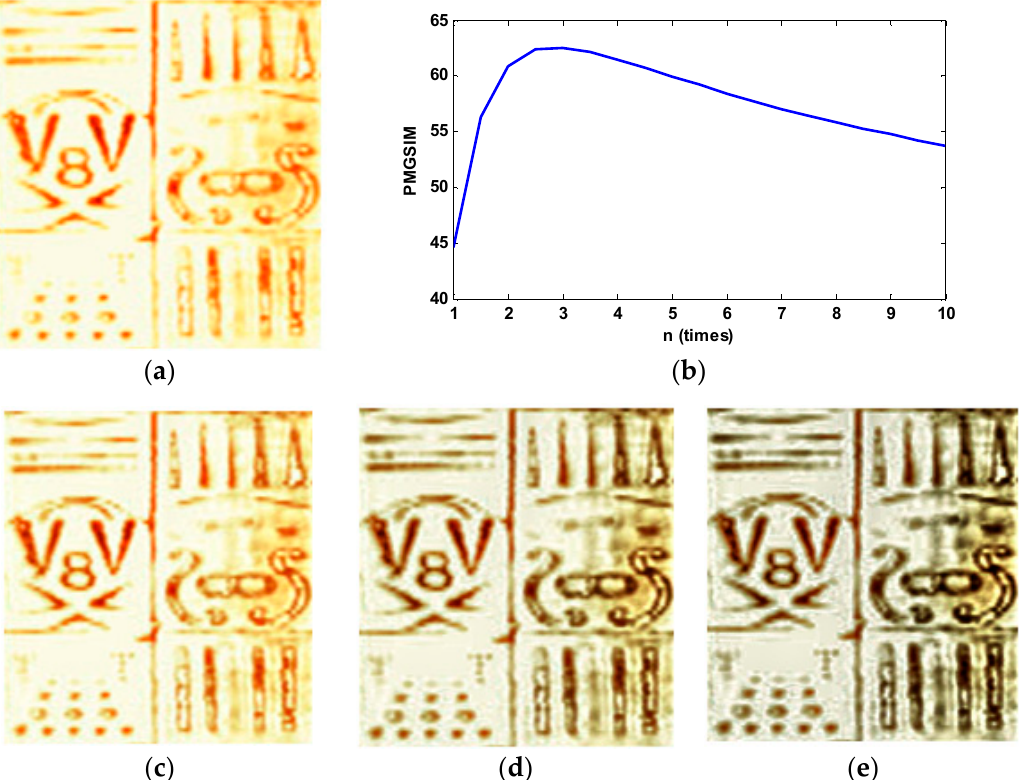
Figure 6. Examples of the proposed POSHEOC with different n values. ( a ) The original ultrasonic logging image; ( b ) PMGSIM of the enhanced image with different n values; ( c ) The enhanced result of the proposed POSHEOC with n = 1.5; ( d ) The enhanced result of the proposed POSHEOC with n = 3; ( e ) The enhanced result of the proposed POSHEOC with n = 6.